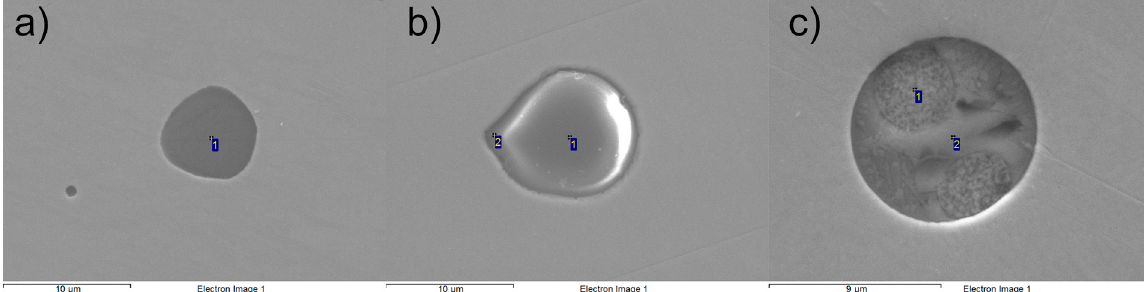
Figure 5. Oxide compositions of NMIs observed in ( a ) Sample #1, ( b ) Sample #2, and ( c ) Sample #3.